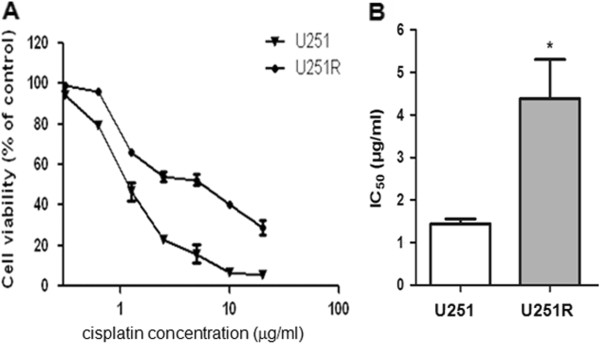
Characterization of the induced cisplatin-resistant U251 cells. (A) U251 and U251R cells were treated with indicated concentration of cisplatin for 72 hours and cell viability was tested by MTT. (B) IC50 of cisplatin in U251 and U251R cells was calculated.